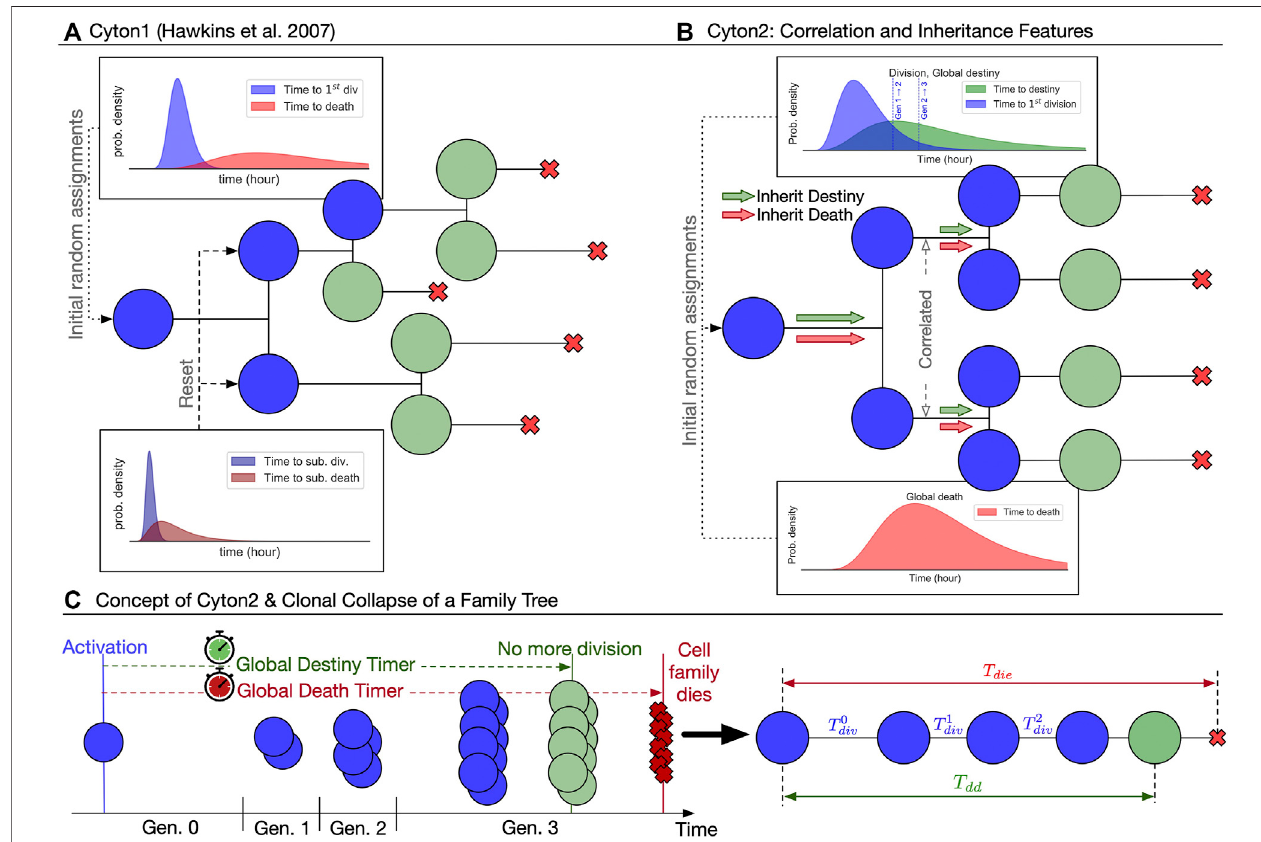
FIGURE 1 | Overview of the two Cyton models. (A) The original Cyton model (Hawkins et al., 2007) where stochastic times to divide and to die are chosen independently after each cell division. Cells cease their motivation to divide based on division-counting mechanism. (B) The Cyton2 model incorporates signi fi cant correlationindivisiontimesbetweensiblings,aswellasfamilialinheritanceofdeathanddivisiondestinytimes. (C) Aconsequenceofthecorrelationandinheritanceisthat the resulting family trees areheterogeneous, but highly concordant.By exploiting thisproperty, afamily tree canbe summarised bysubstituting the averagevalues of its times and fate at each generation. An example of clonally collapsed family tree and its key variables is